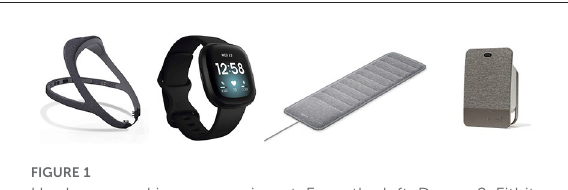
FIGURE1 Hardware used in our experiment. From the left: Dreem 2, Fitbit Versa 3, Withings Sleep Analyzer and SleepScore Max.